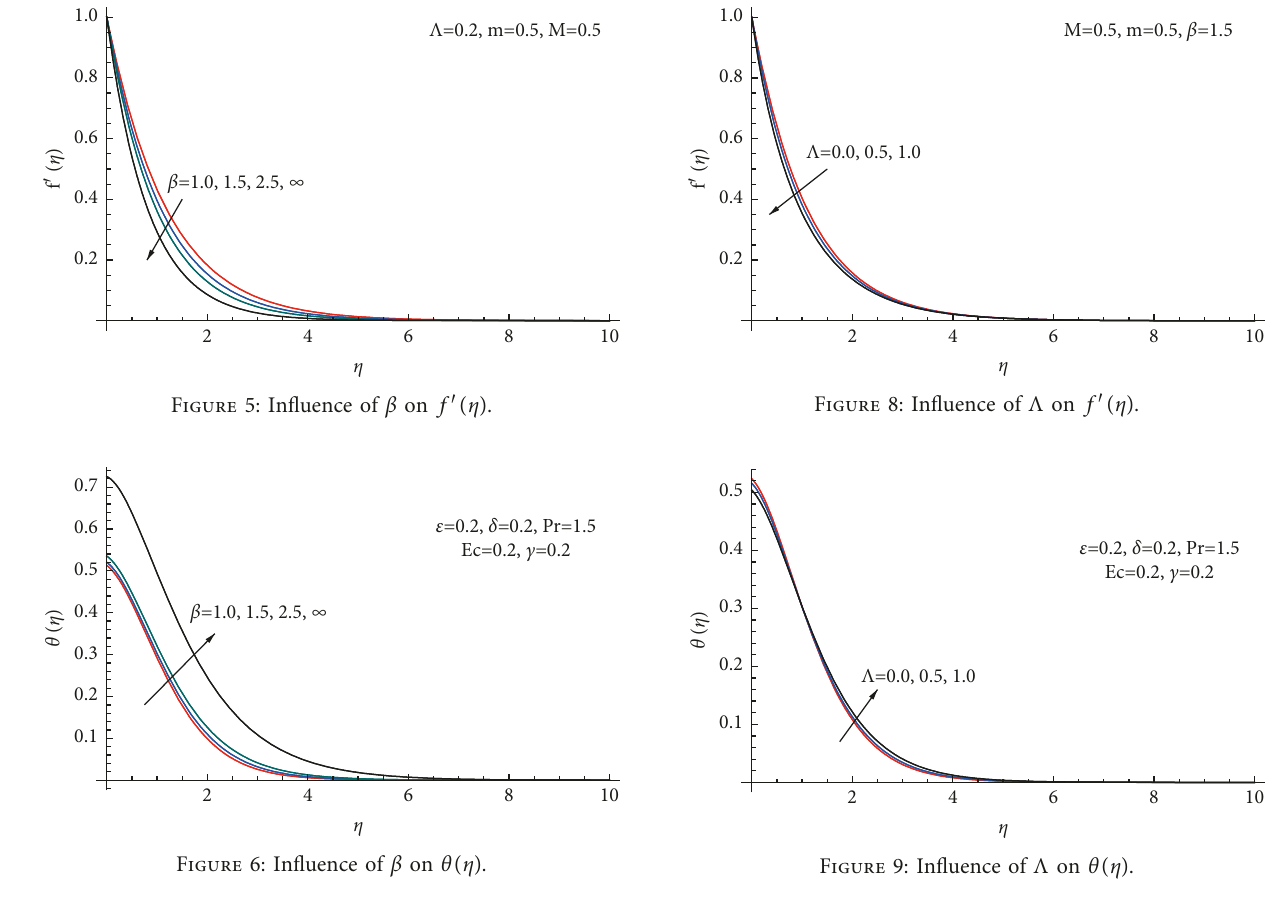
Figure 8: Influence of Λ on f ′ ( η ) .